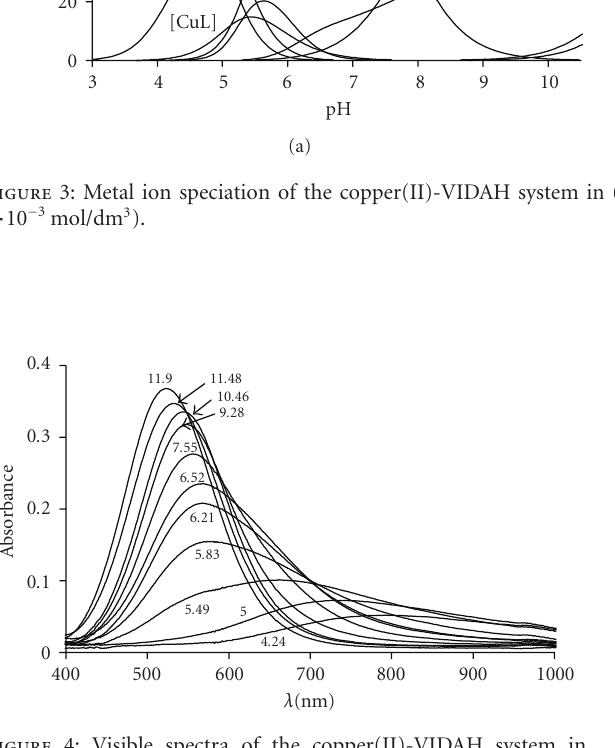
Figure 4: Visible spectra of the copper(II)-VIDAH system in equimolar samples at di ff erent pH values (c L = 2 · 10 − 3 mol/dm 3 ).